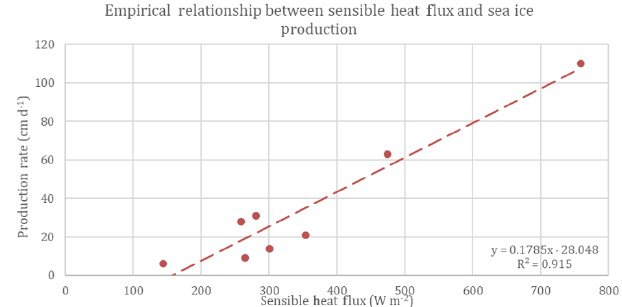
Figure 11. Empirical relationship between sensible heat flux and sea ice production: production rate = 0 . 1785 Q s − 28 . 048; R 2 is